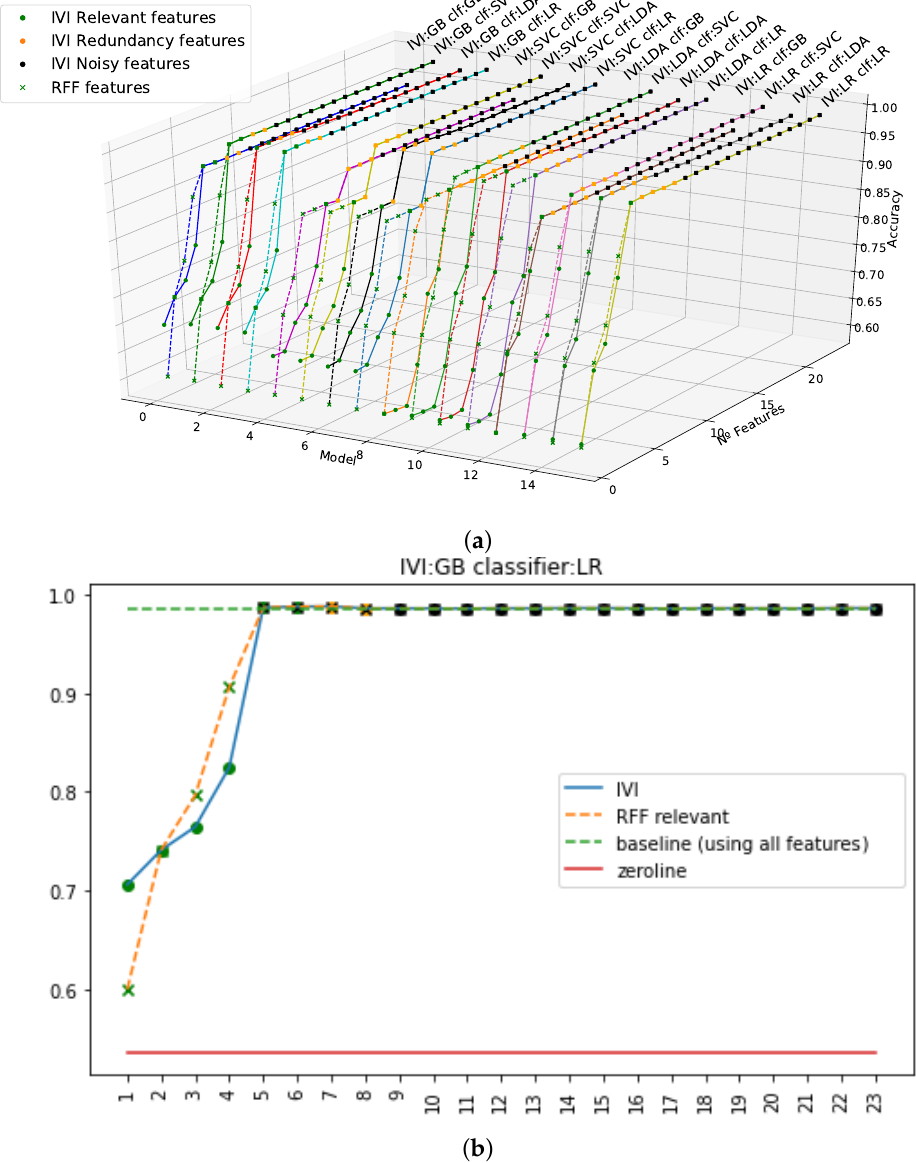
Figure 3. Graphical results for accuracy through of incorporation of the features in sequential order of relevance to RFF models, enabling us see the evolution in accuracy as each feature is added. In 3D plots ( a ), we can see number of features on the x-axis, on the y-axis are the different ML algorithms (GB, SVC, LDA, and LR), and the accuracy is on the z-axis. For each ML algorithm, we present the evolution of features selected in IVI as a continuous line and the features selected by the filter as a dashed line. In ( b ), we show a comparison between filters and IVI. For clarity and simplicity, we only show one comparative sample. In ( b ), the red line represents a dummy classifier that makes predictions with the most frequent class, and the green dashed line shows the results of the classifier trained with all